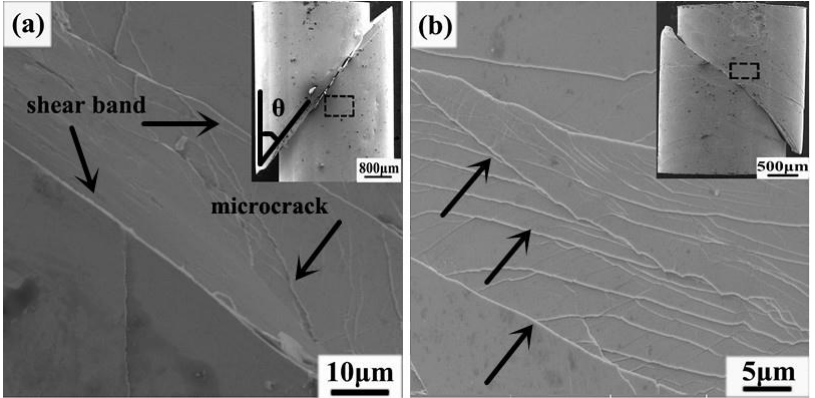
Figure 2. SEM images of the lateral surfaces of the fractured BMGs deformed at strain rates of 2 × 10 −3 , and 2 × 10 −4 ·s −1 ,